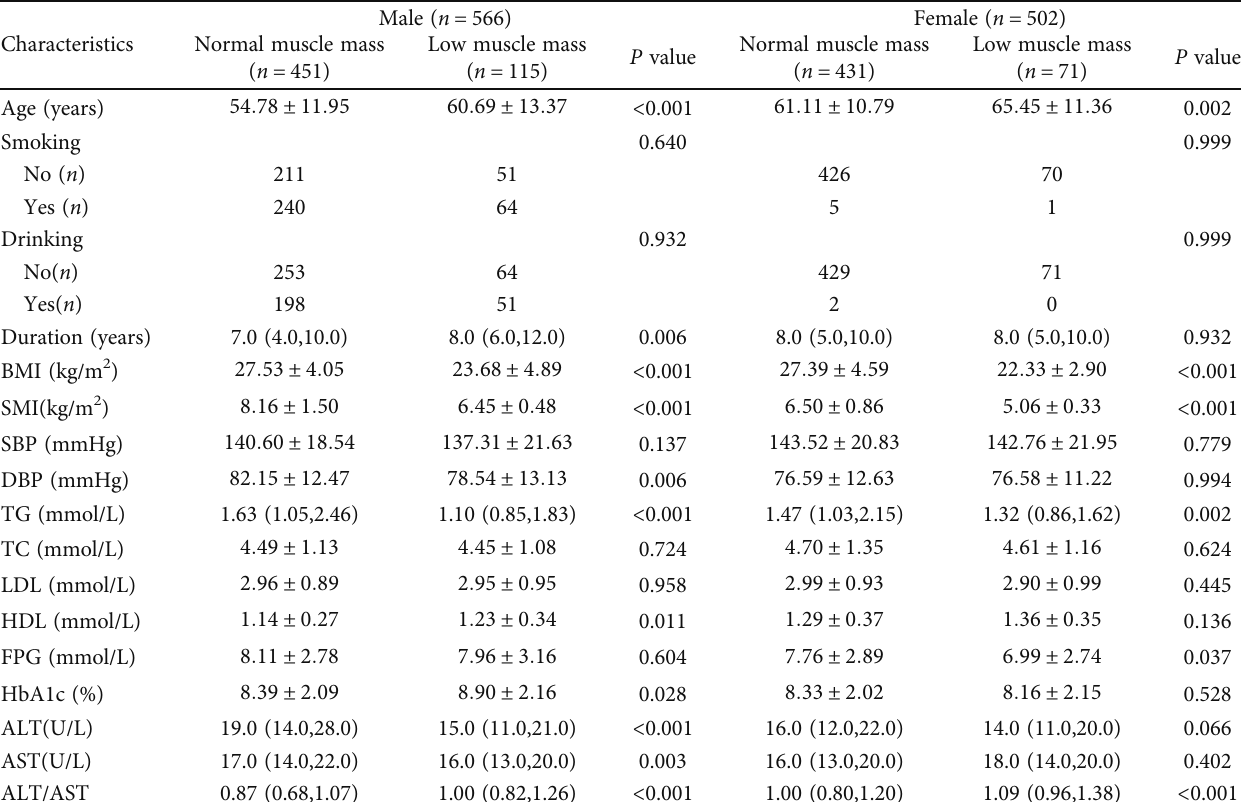
Table 1: The characteristics of patients with and without low muscle mass.